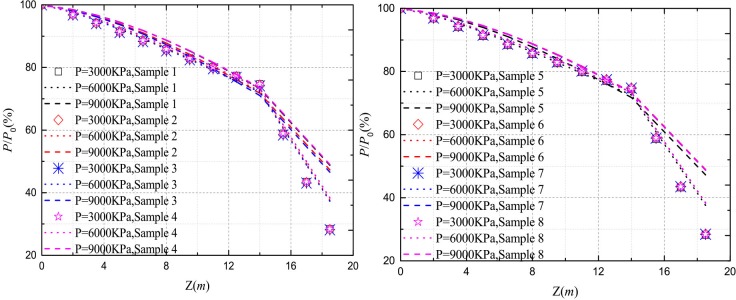
Effect of the samples on P/P0-z curves.